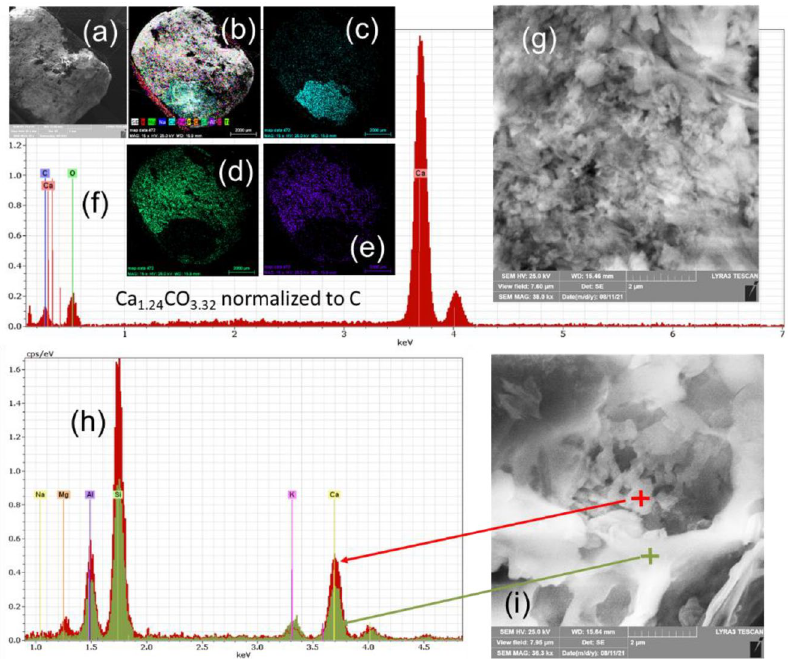
Figure 13. SEM image ( a ) and elemental maps for: ( c ) Ca; ( d ) O; ( e ) C. In ( b ) is presented RGB image obtained by overlapping the maps for individual elements; ( f ) EDX spectrum taken on the Ca-rich grain; ( g ) SEM image at high magnification showing nanostructuring of the Ca-rich grain; ( h ) EDX spectra taken inside and outside a pore shown in ( i